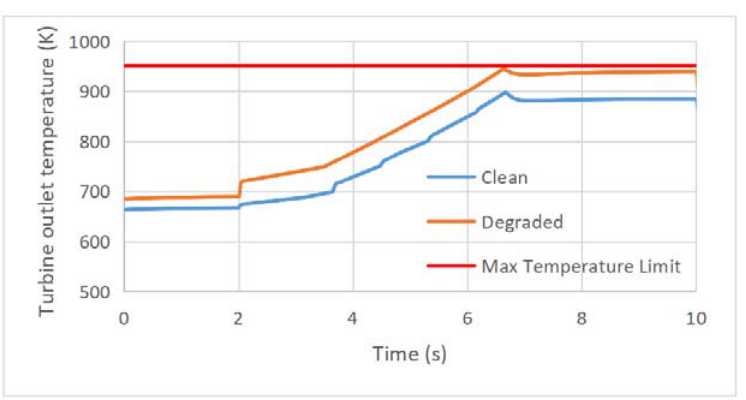
Figure 25. Comparison of the thrust of the clean engine with the clean controller and the degraded engine with the adjusted controller.